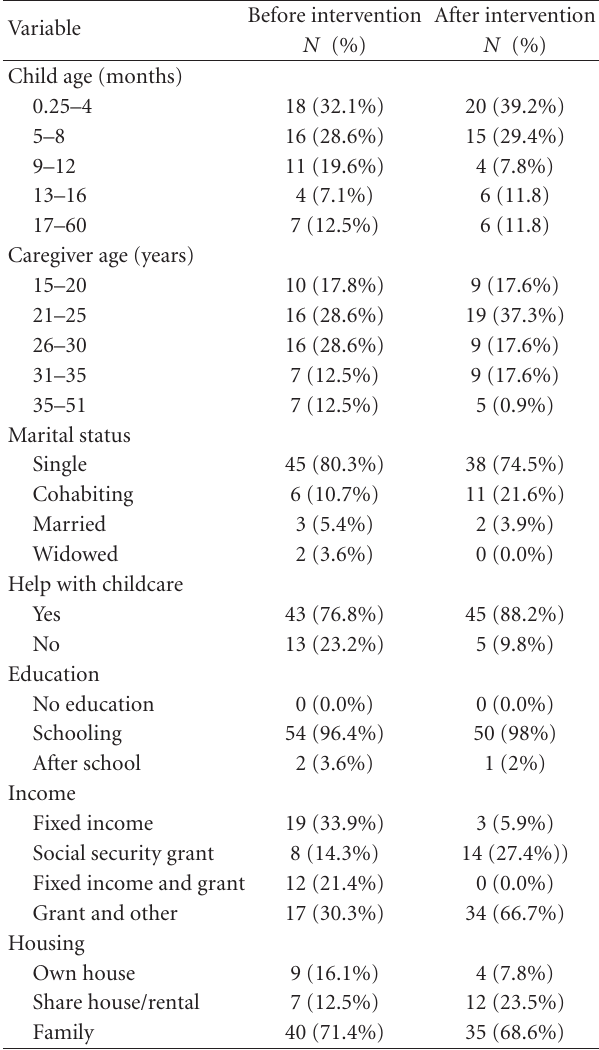
Table 1: Caregiver demographic information by study phase. Variable Table 3 for descriptive data on the alarm distress baby